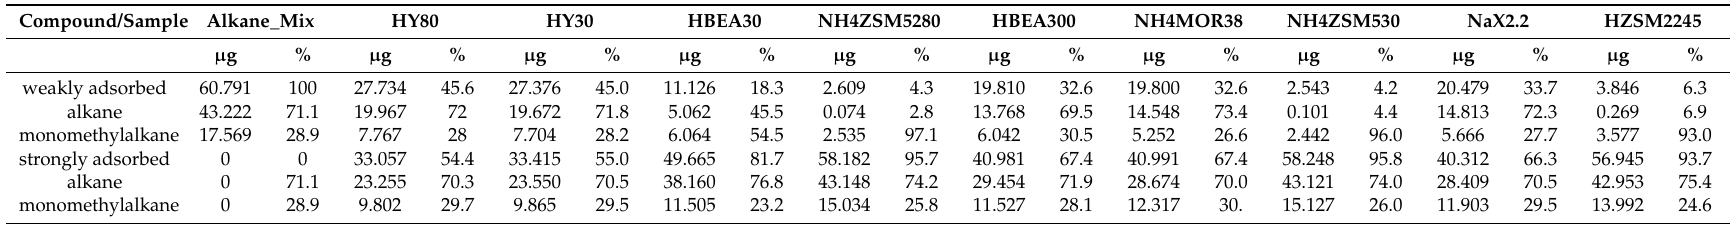
Table 3. Distribution ( µ g/500 µ L and %) of the compounds present in the synthetic alkane mixture (alkane_mix) and in the zeolite samples loaded with this solution. Components are grouped as weakly adsorbed (recuperated in the n-hexane extract) and strongly adsorbed (not recuperated in the n-hexane extract) components. These groups are then further divided by class, alkane and monomethylalkane, since these were the only types of compounds present in the alkane